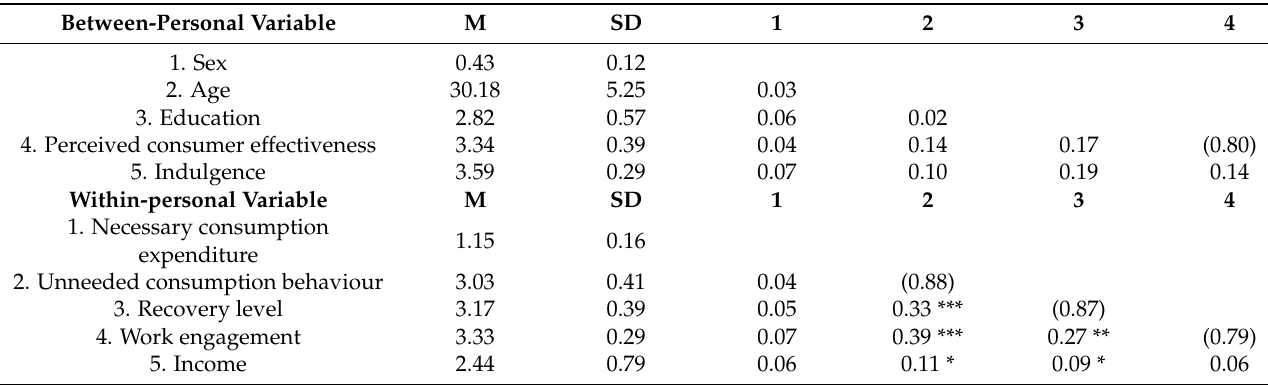
Table 1. Descriptive Statistics, correlations and reliability.